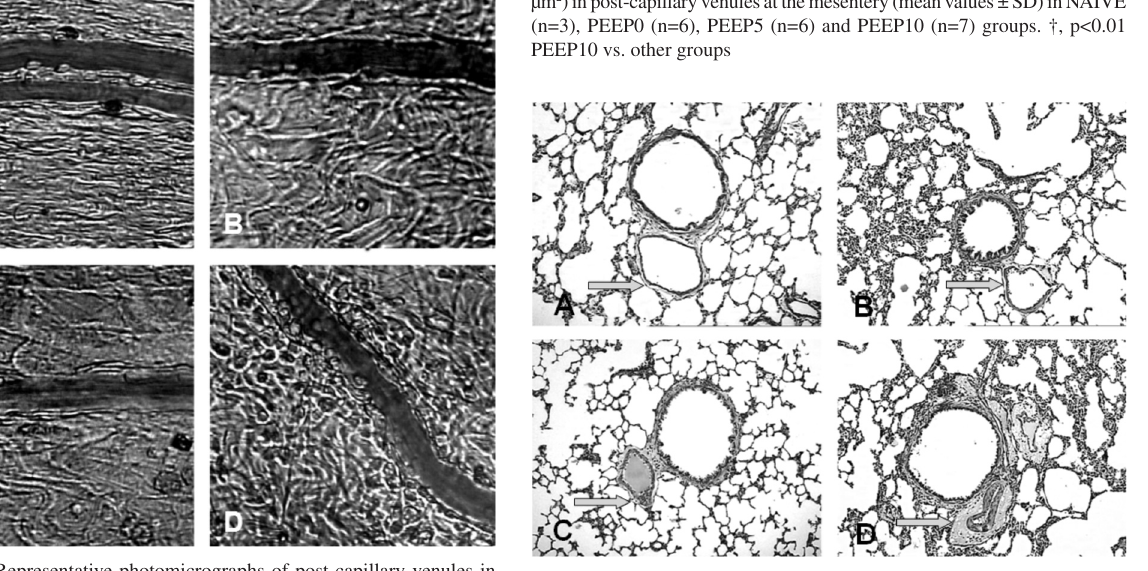
Figure 4 - Representative photomicrographs of rat lung histological sections. (A) NAIVE; (B) PEEP0; (C) PEEP5; (D) PEEP10. Presence of inflammatory cells and edema (arrows) in PEEP groups compared with the NAIVE group. Original magnification x100,